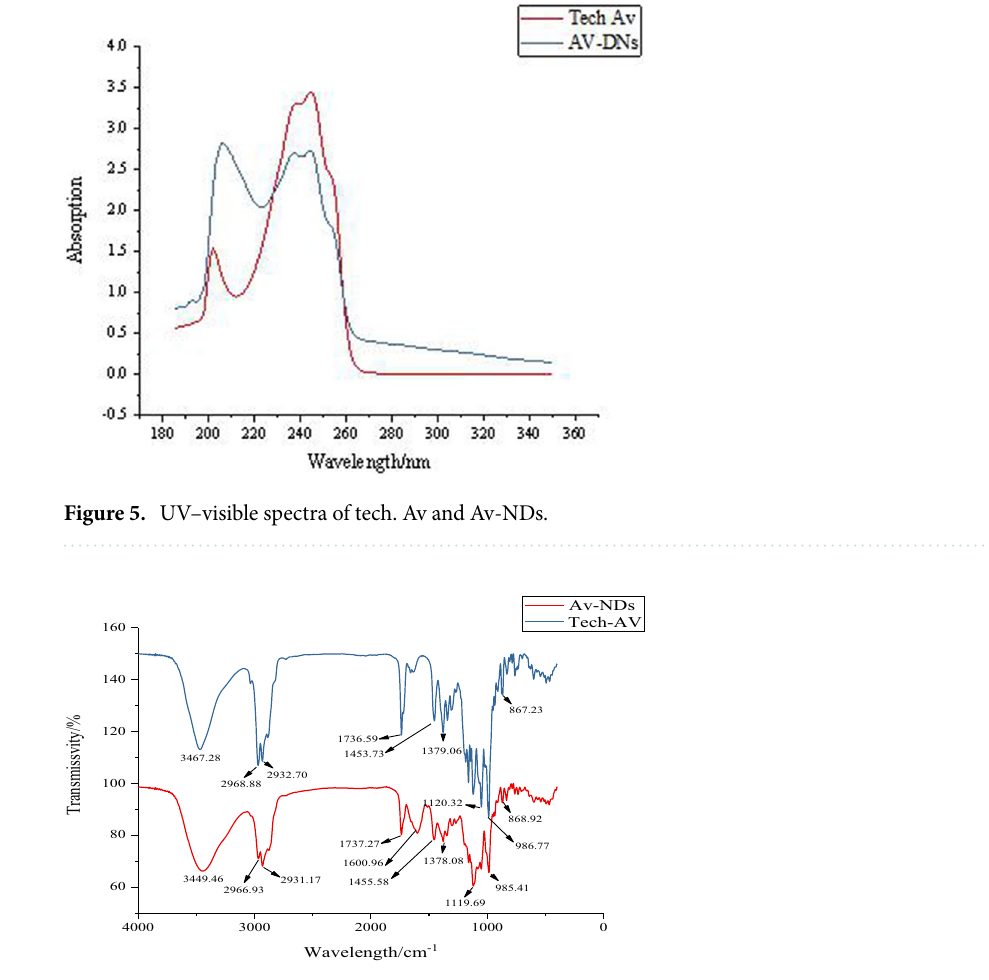
Figure 6. FTIR spectra of Av-NDs and tech.